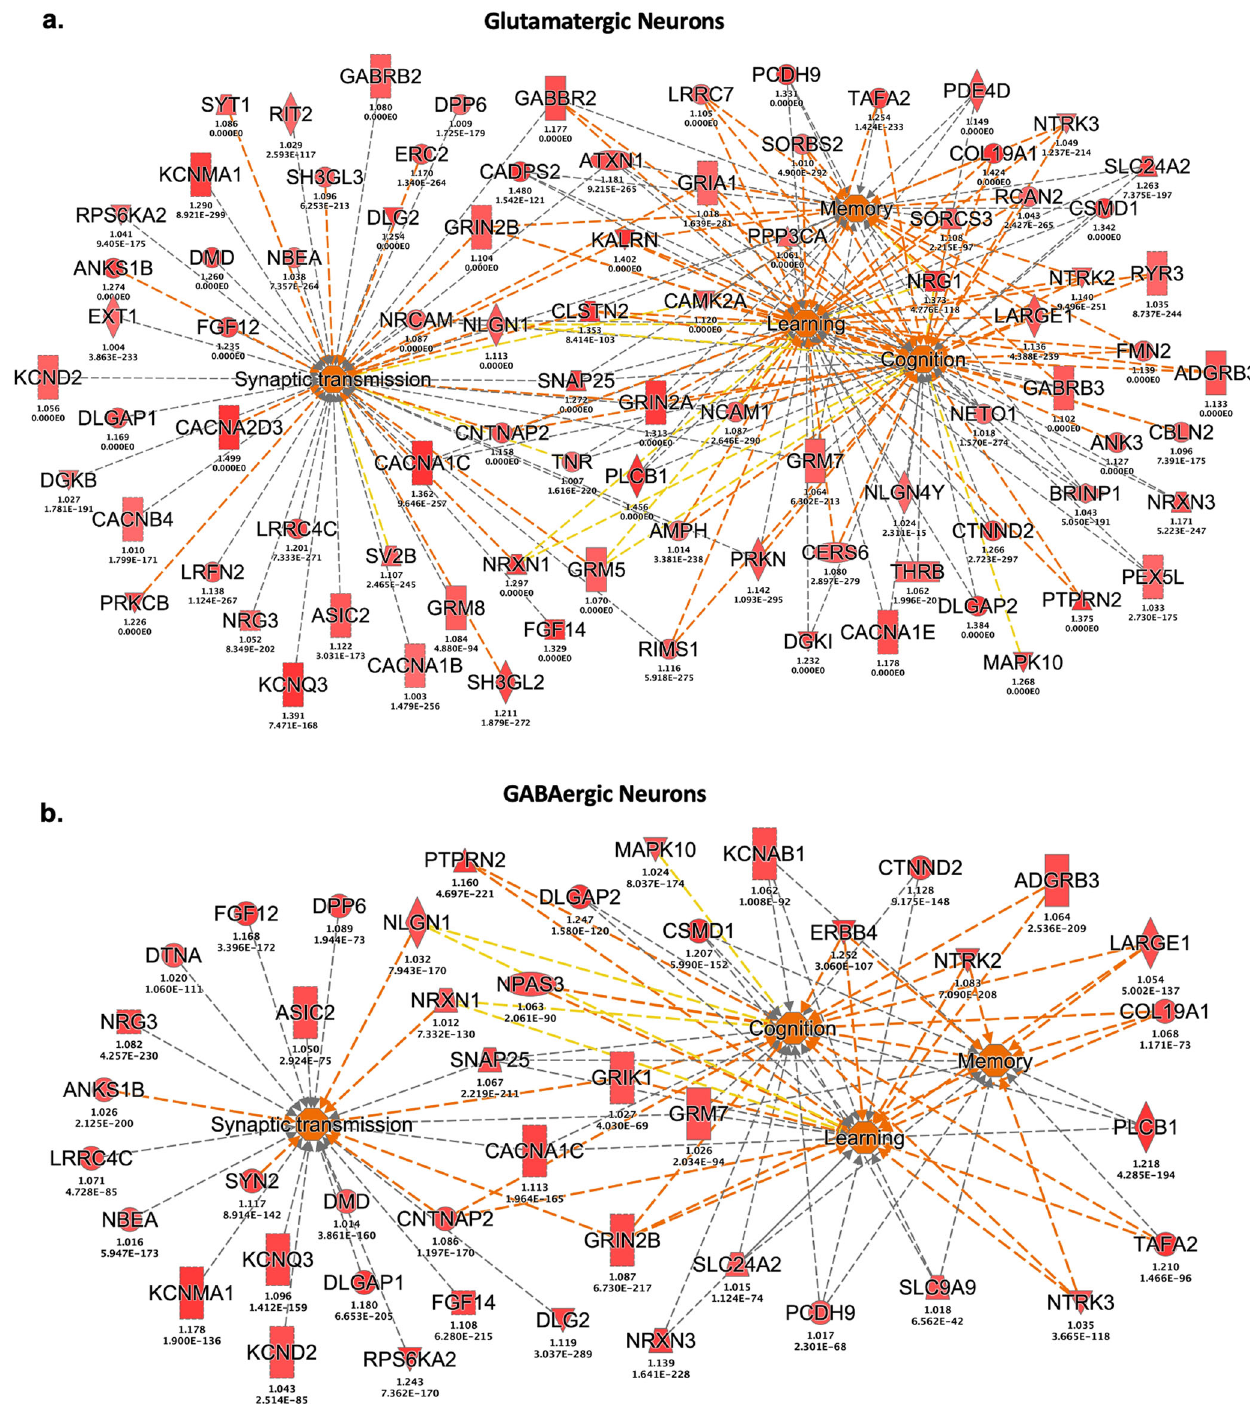
Fig. 3 Diseases and functions associated with the differentially expressed genes from glutamatergic and GABAergic neurons. Differentially expressed genes between brains from patients with and without memory impairment converge on memory-related processes as predicted through IPA in both ( a ) glutamatergic and ( b ) GABAergic